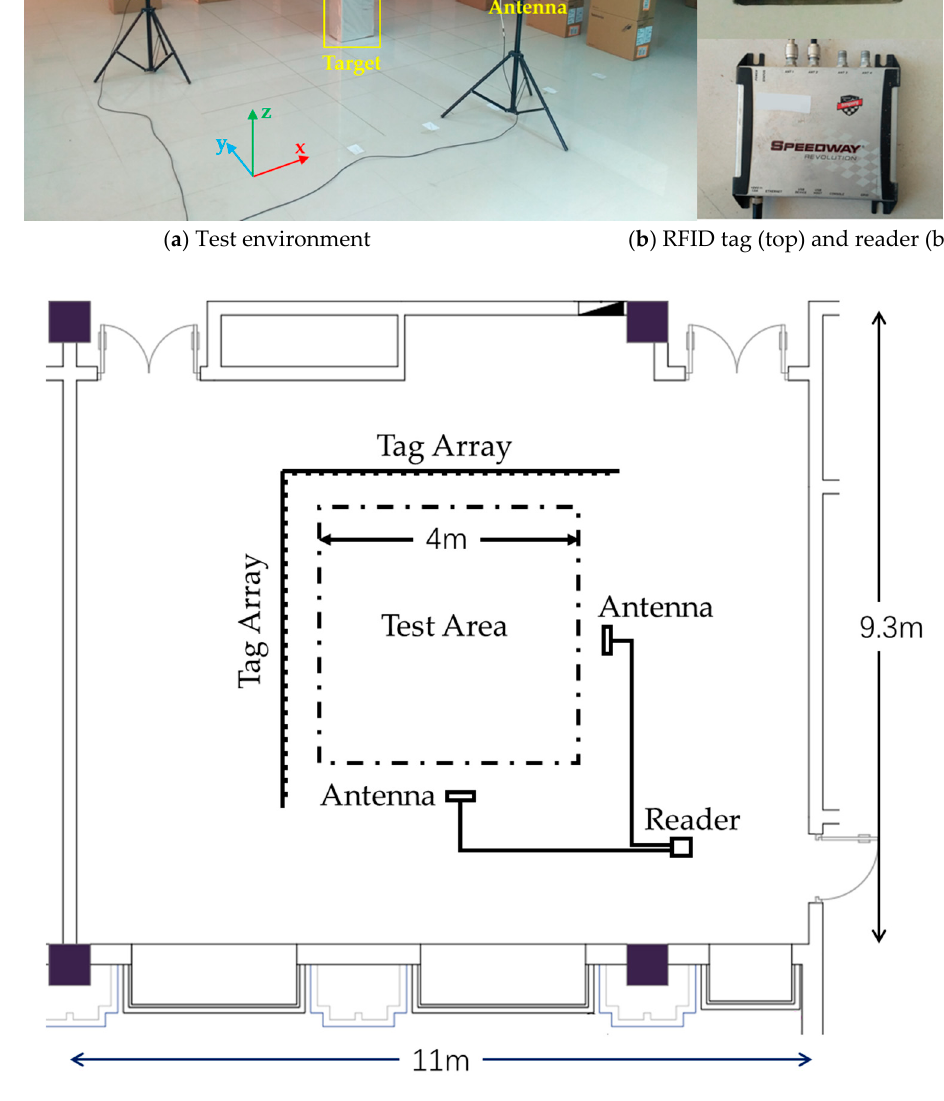
Figure 3. ( a ) Wall-mounted tag arrays and antennas in WallSense. ( b ) Tags are attached onto foamed plastic pads. The figure also shows the R420 reader used in our experiments. ( c ) Deployment layouts with the positions of tag arrays, antennas and test area